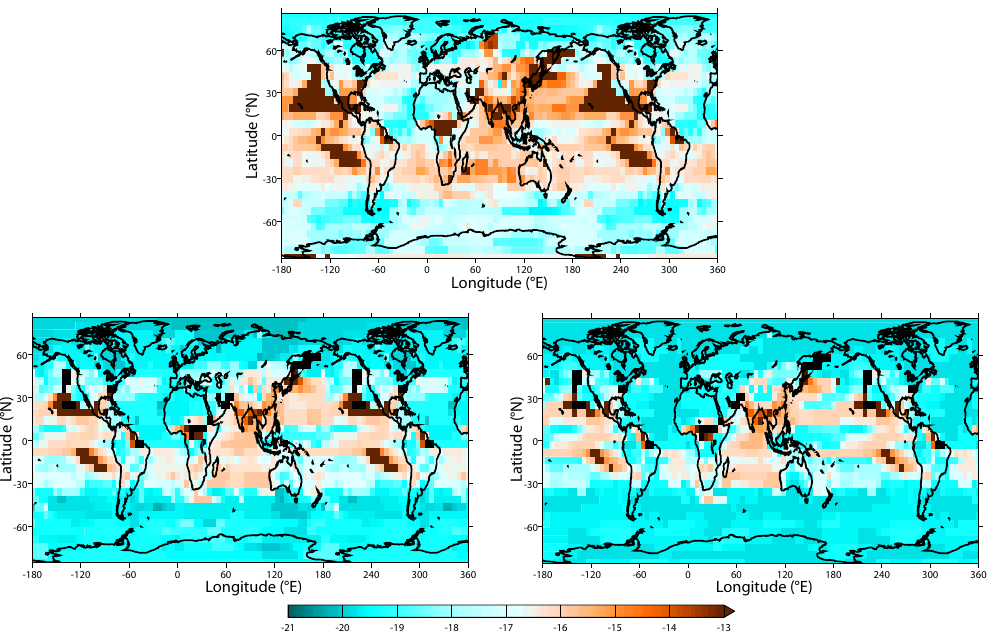
Fig. 9. Impact on sample size on the timing of the first significant temperature warming during deglaciation. From top left to bottom right the sample sizes are: 25 (top), 100 (bottom left) and 200 (bottom right) years. Color scale is the date inkyrs BP. Black denotes regions without significant warming over the